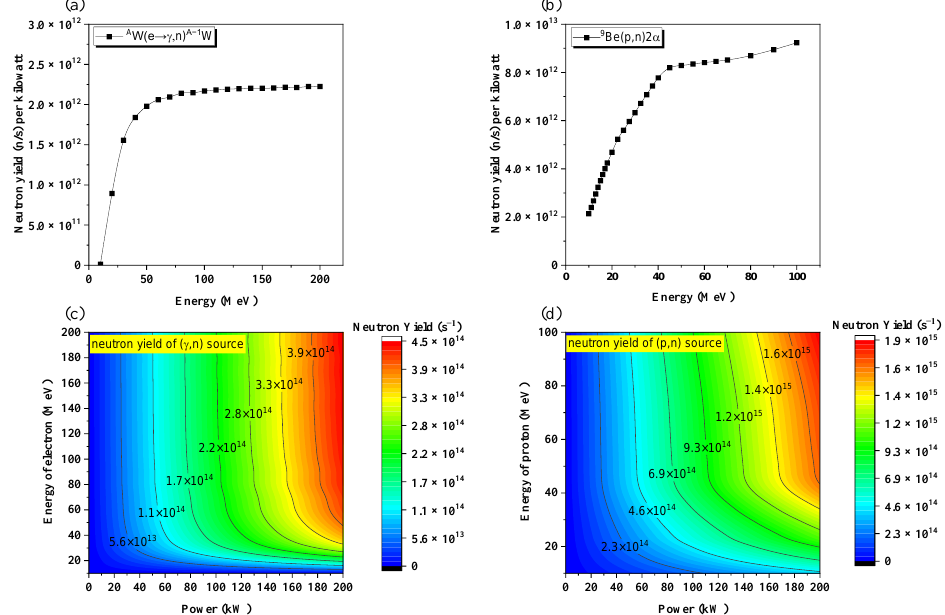
Figure 1. ( a ) The (e → γ ,n) reaction yield with tungsten target; ( b ) the (p,n) reaction yield with beryllium target; ( c ) the yield of a neutron source with different energies and powers of incident electrons; ( d ) the yield of a neutron source with different energies and powers of incident protons.